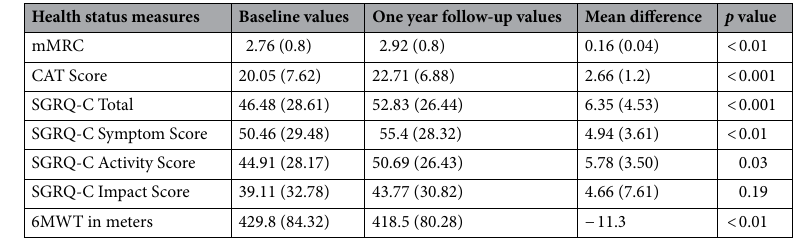
Table 3. Change in health status measures scores from baseline to one year follow-up. Data are presented as mean (SD) unless otherwise stated. COPD, Chronic Obstructive Pulmonary Disease; mMRC, modified medical research council dyspnoea scale; CAT, COPD assessment test; SGRQ-C, St George’s Respiratory COPD specific